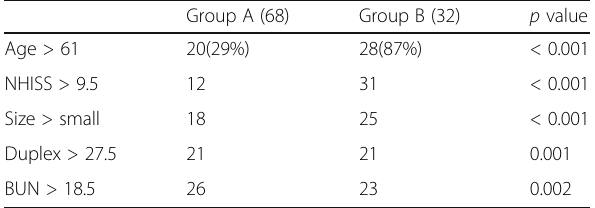
Table 8 Prevalence of predictors of infection in our